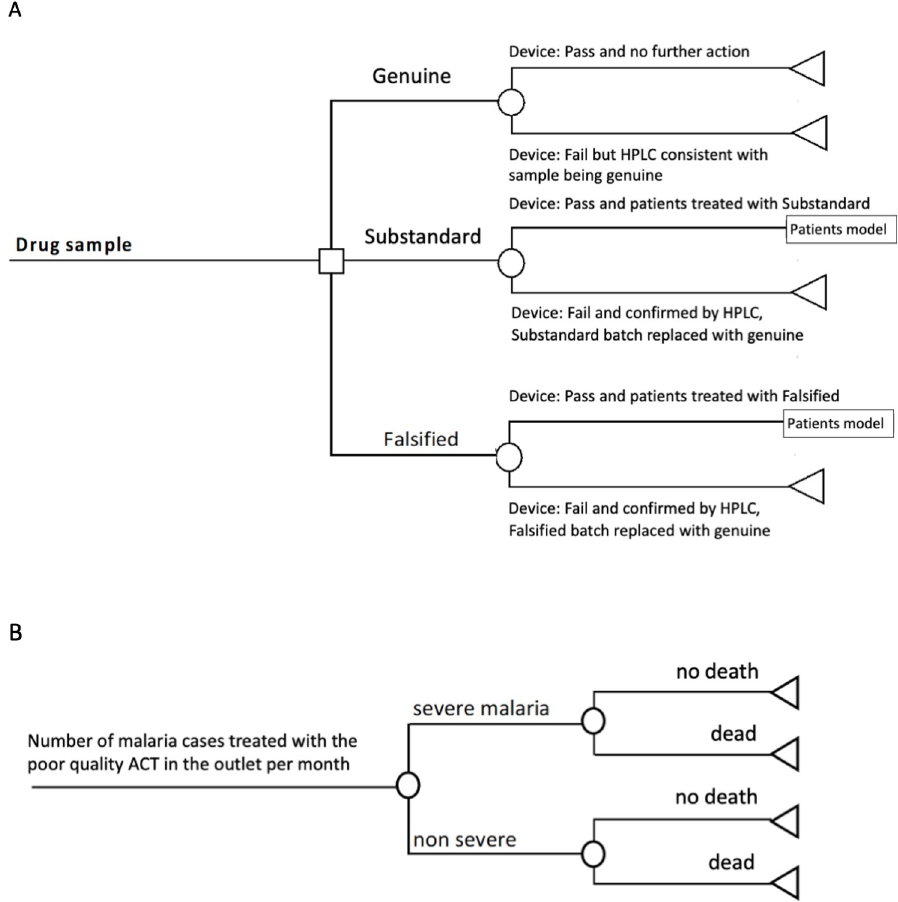
Fig 1. Decision analytic model for drug sampling at pharmacy (A Medicines Model) and malarial illness (B Patients